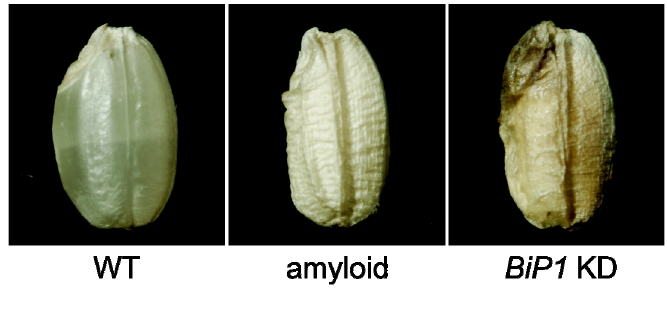
Figure 1. Endoplasmic reticulum (ER) stress-related phenotypes of transgenic rice seeds. Transgenic rice seeds in which a mammalian amyloid is produced as an ER retention protein or the BiP1 gene is knocked down (KD) specifically in the endosperm. These transgenic rice seeds show the following phenotypes: opaque and shrunken phenotype, decreased starch content, decreased seed storage proteins (protein and mRNA levels) and induction of ERQC-related